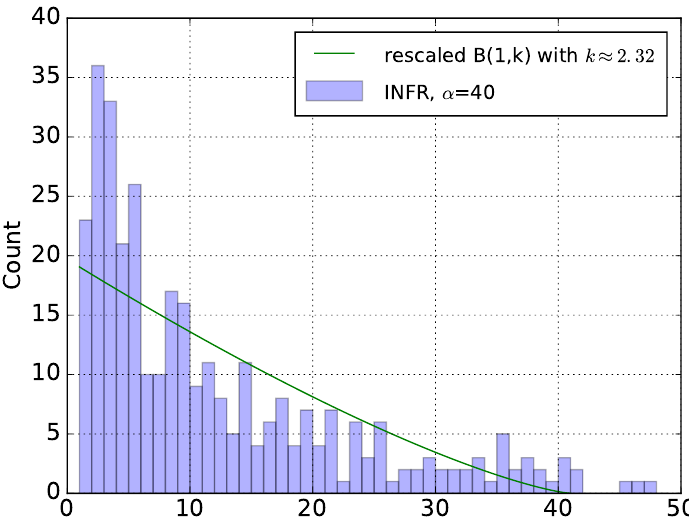
Figure 6. Distribution of the number of sent beacon with the rescaled Beta distribution.